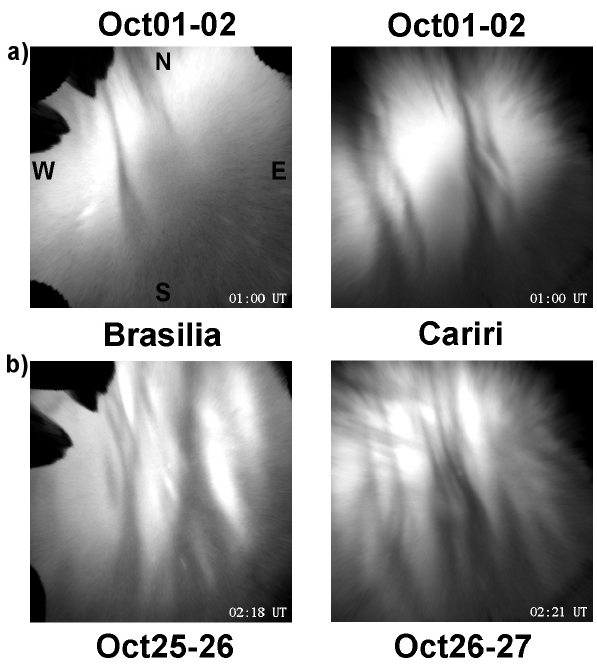
Fig. 2. Examples of unwarped OI (630nm) all-sky im- ages (1500 × 1500km), showing ionospheric depletion structures, recorded from Brasilia (left) and Cariri (right) during the first phase (a) and second phase (b) of the campaign.